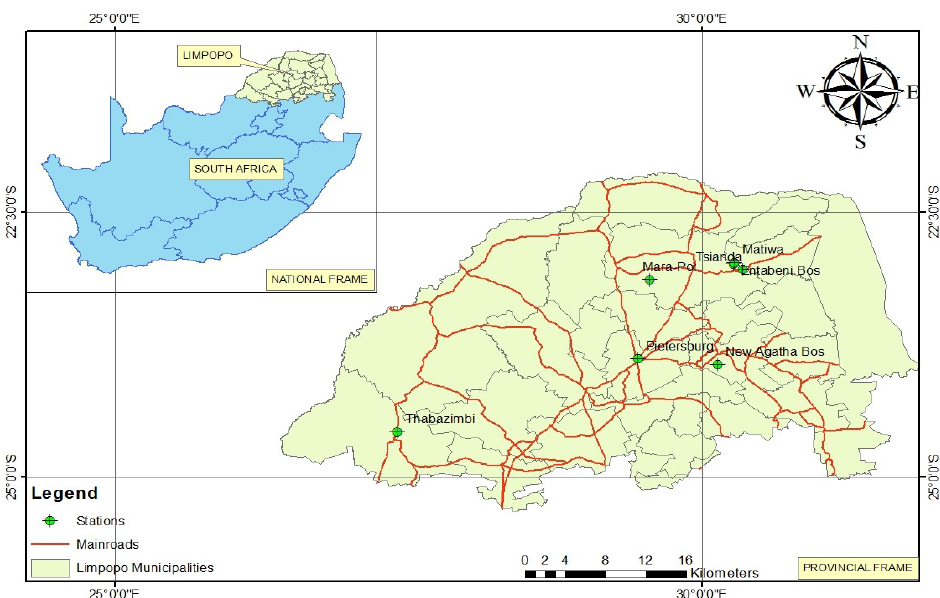
Figure 2. SAWS meteorological stations used in this study. Source: authors’ creation.